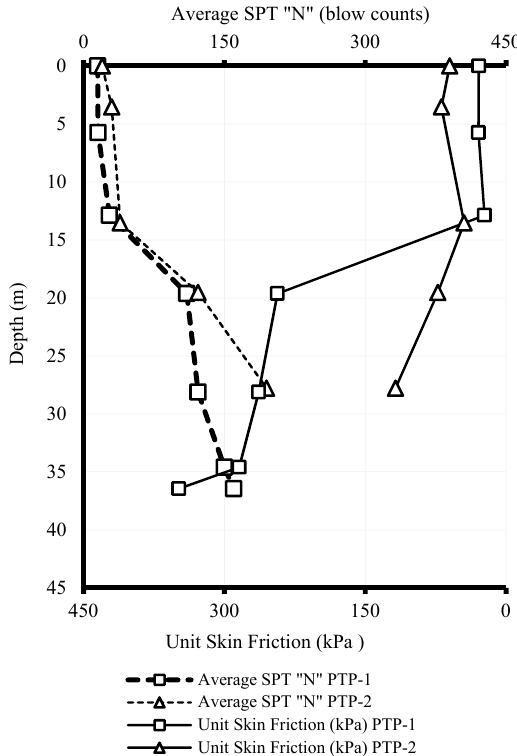
Figure 17. Average number of standard penetration test and the unit skin friction in BP# 1 and BP# 2.